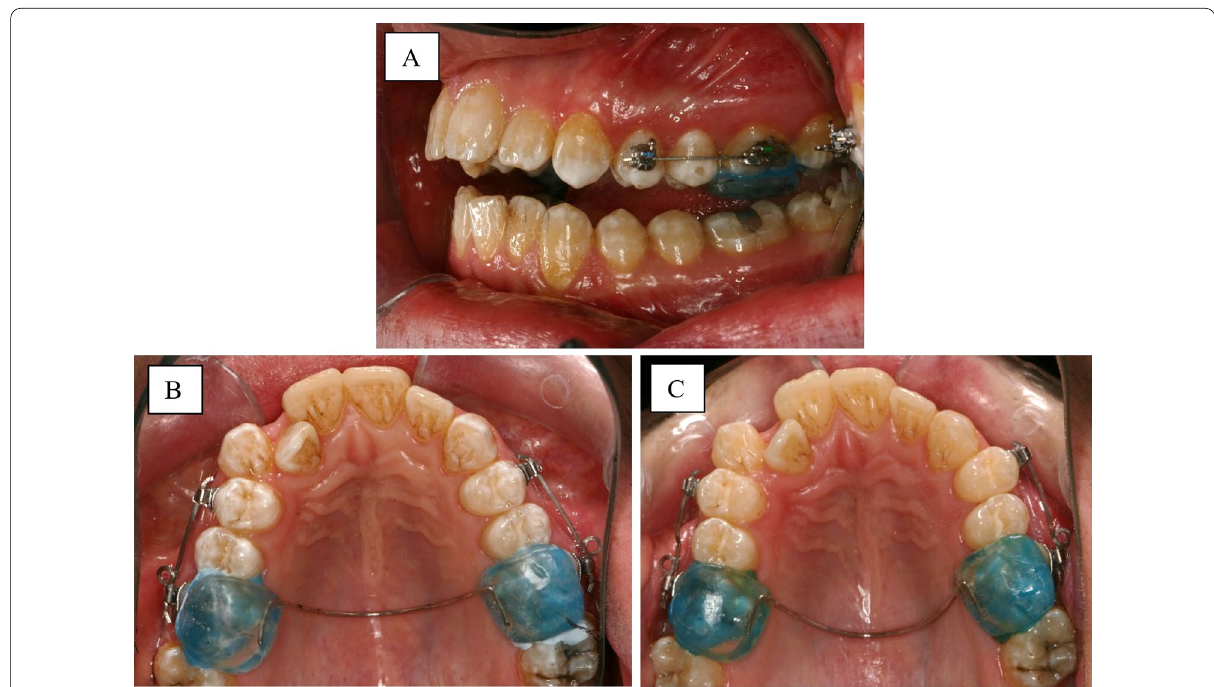
Fig. 2 Intra‑oral photographs of orthodontic appliances. A Buccal view on the day of appliance insertion, B occlusal view on the day of appliance insertion, C occlusal view after 12 weeks of buccal tipping